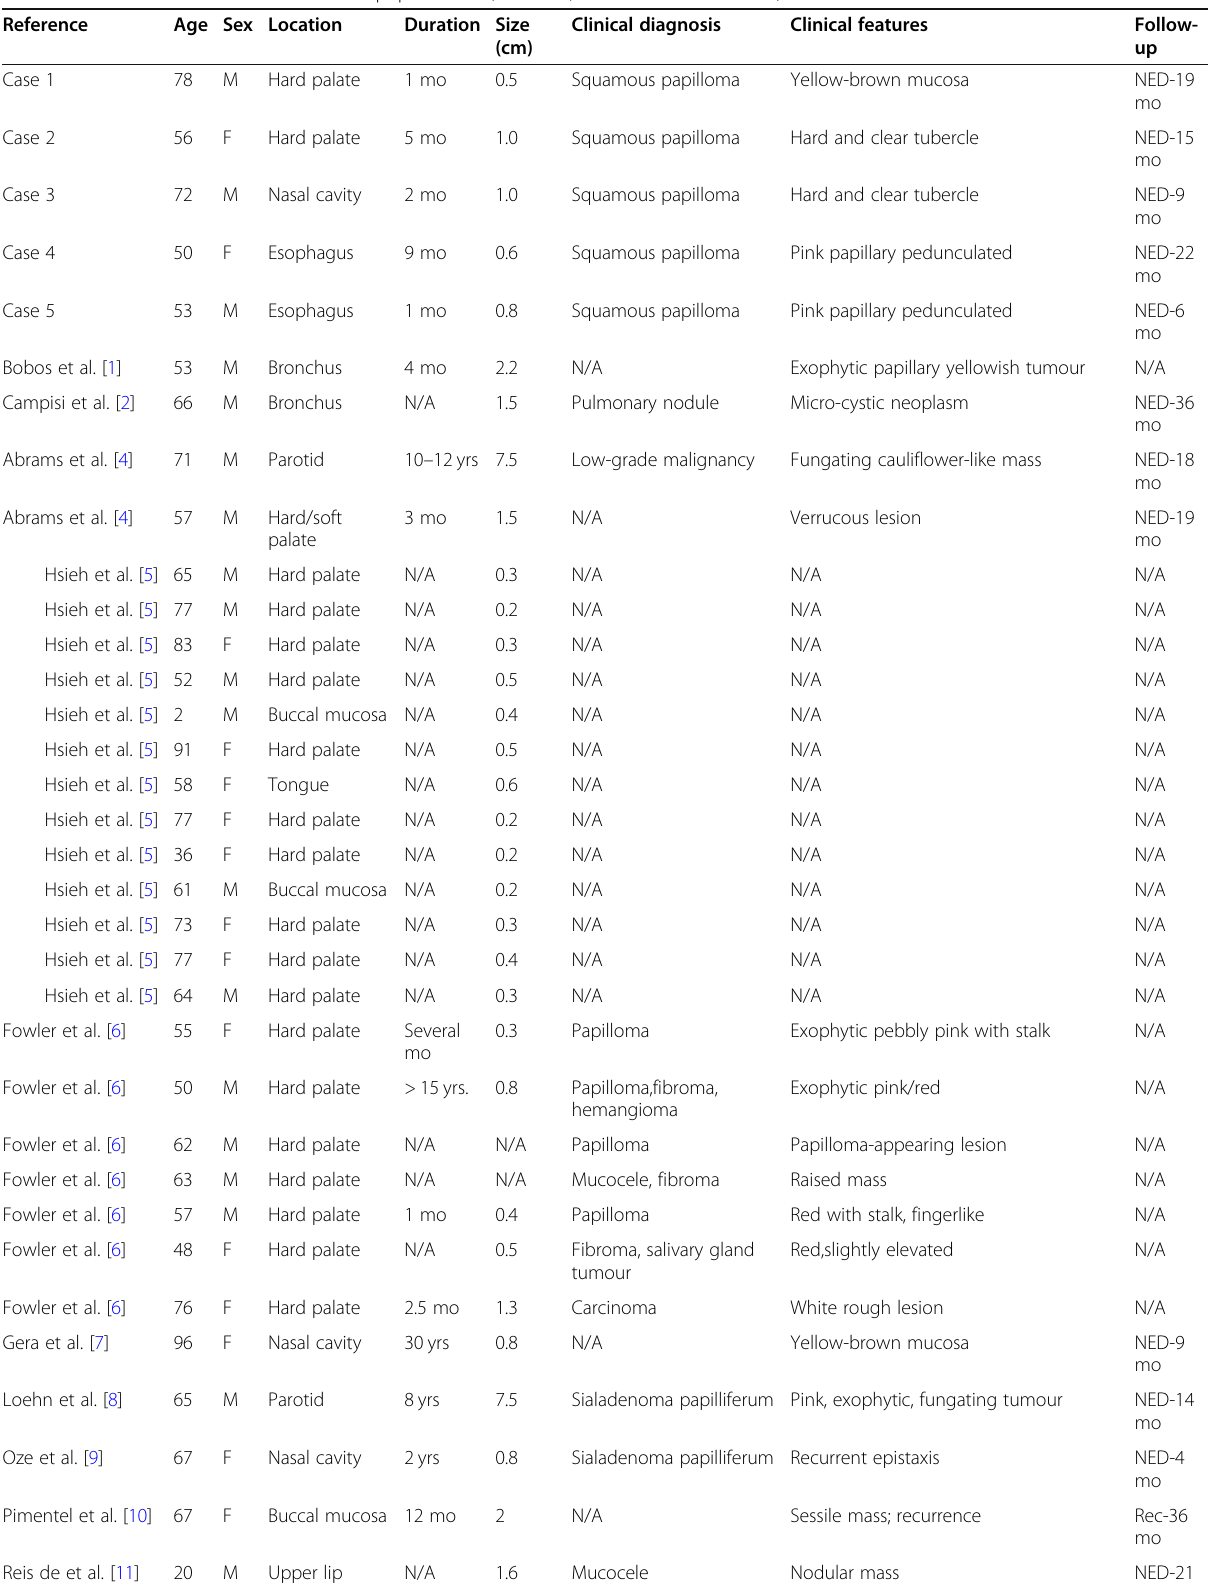
Table 1 Clinical features of sialadenoma papilliferum (95 cases, but 94 cases